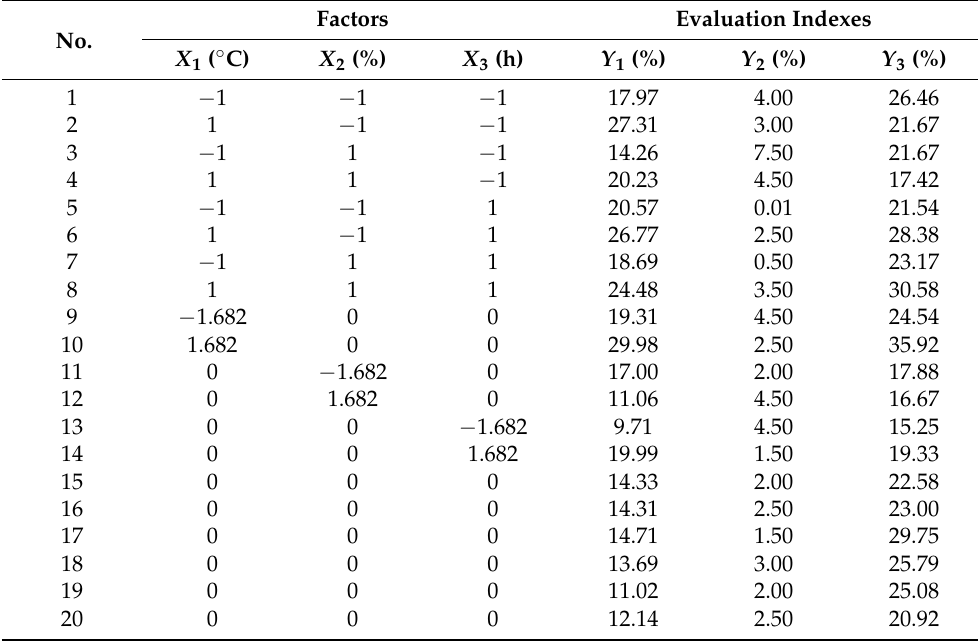
Table 4. Experiment plan and results.